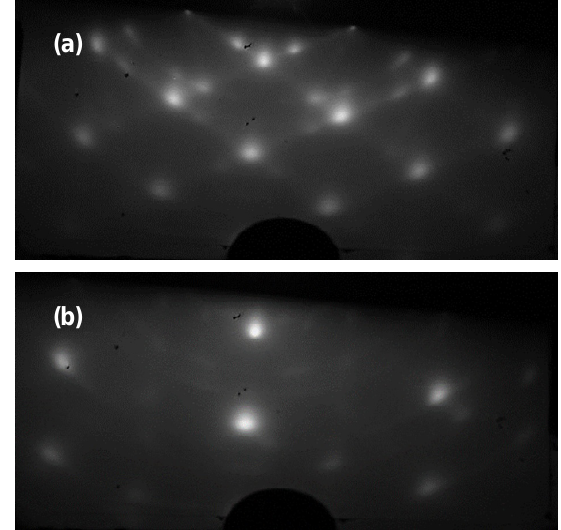
Fig. 6. RHEED patterns of SiC samples grown on Si(100)/r-plane Al O ; projected onto the axis [001] 2 3 (a) and projected onto the axis [011] (b).The pat- terns are similar for both Fab-2-R-plane and Fab-1- R-plane sapphire.